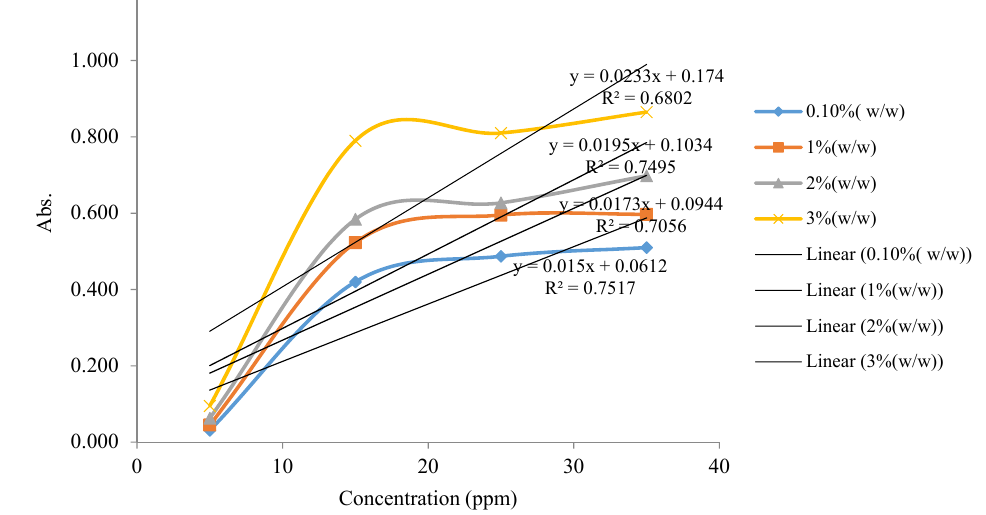
Fig. 3: Proper limit for ratio of ASBE to dye solution